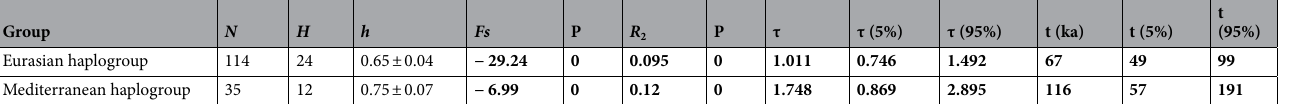
Table 1. Results of the tests of demographic equilibrium and mismatch analysis in mtDNA phylogeographic groups. N , number of mtDNA sequences; H , number of unique mtDNA haplotypes; h , mtDNA haplotype diversity (± SD). Fs , Fu’s FS statistic; R 2 , Rozas and Ramon-Onsins’ R 2 statistic; τ, sudden demographic expansion parameter, with 5% and 95% confidence limits; t, true time since population expansion, from τ = 2